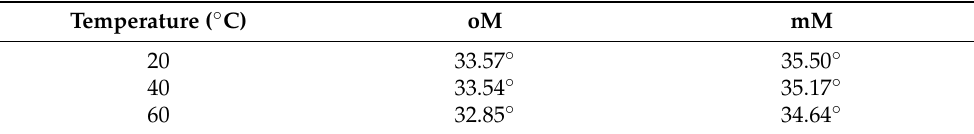
Figure 10. Shearing phase plots at T = 20 ◦ C of: ( a , c , e ) oM; ( b , d , f ) mM. Table 3. Variations of the measured values of effective internal friction angle φ (cid:48)